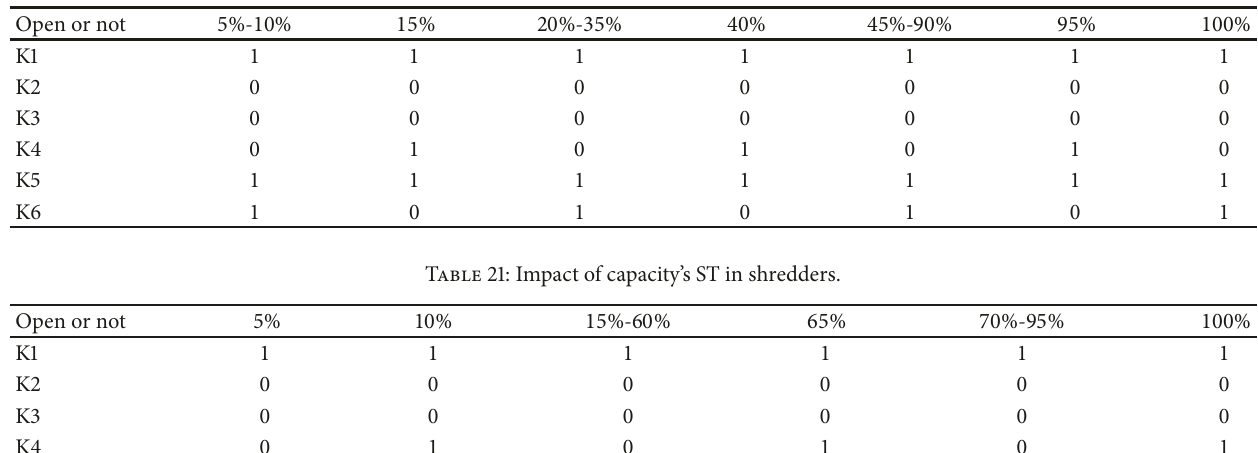
Table 20: Impact of capacity’s ST in dismantlers.